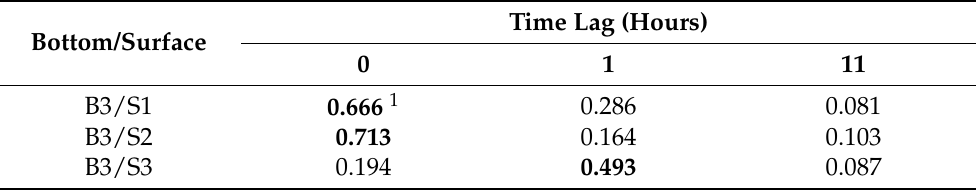
Table 2. Significant ( ≥ 0.05) cross-correlation coefficients for time lag (hours) between prewhitened ( p = 2) time series of water table management at site B (Bottom 3 vs. Surfaces 1, 2, 3) for 2017.